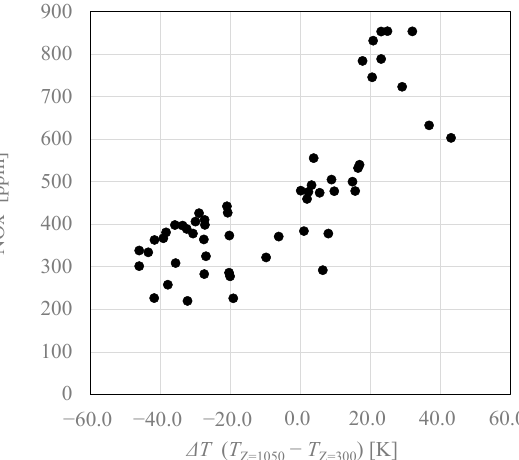
Figure 12. NOx for different ∆ T . Input = 11.63 kW, λ total = 1.2, λ 1 = 0.6. E NH3 = 10~100%, D 2 / D 1 = 0.15, 0.24, 0.29. 0.40, L / D 1 = 1.84, 3.68, 5.51.